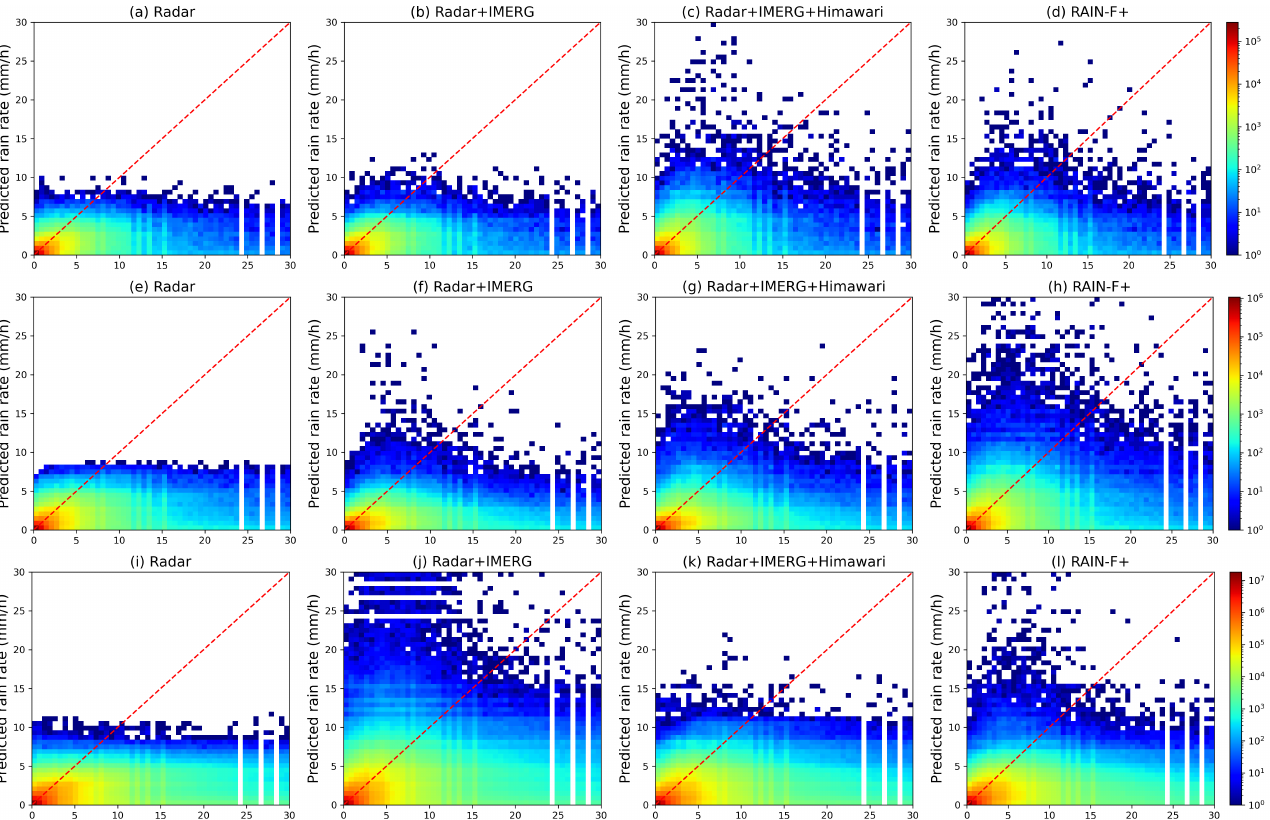
Figure 10. The scatter plots of prediction results depending on the fused data sources and the input resolution of 32 × 32 ( upper row ), 64 × 64 ( middle row ), and 256 × 256 ( bottom row